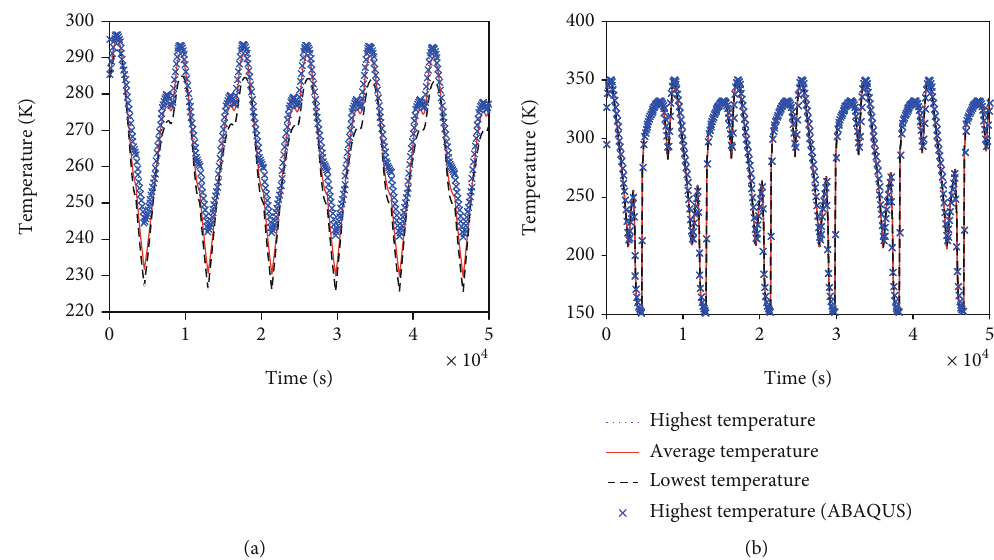
Figure 7: Temperature vs. time graph of the membrane antenna structure in low orbit: (a) support frame; (b) membrane